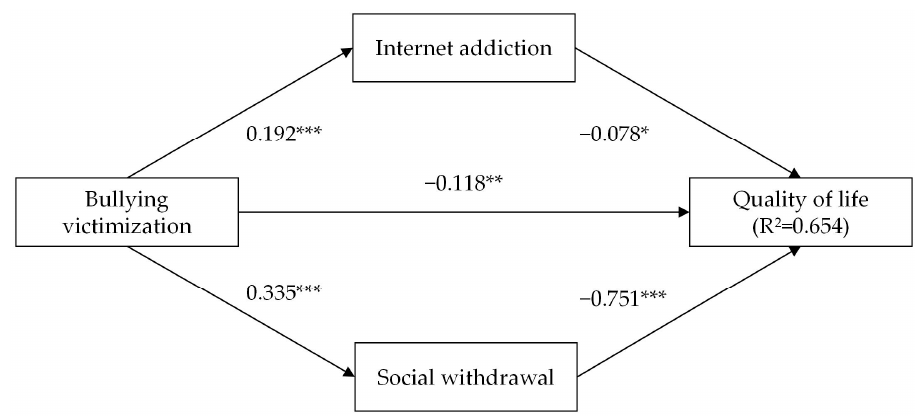
Figure 1. The mediating model (*** p < 0.001; ** p < 0.01; * p < 0.05).